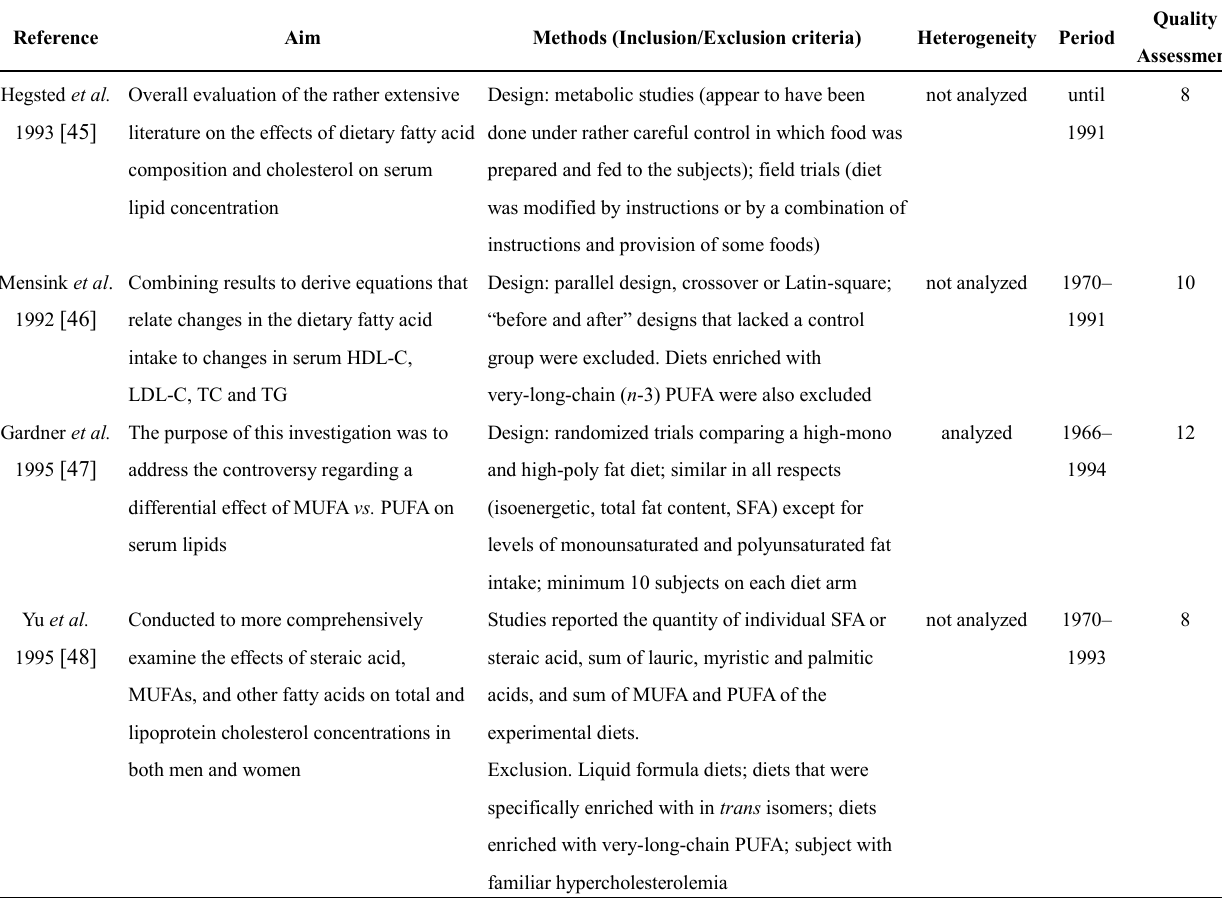
Table 4. Qualitative aspects of the included systematic reviews and